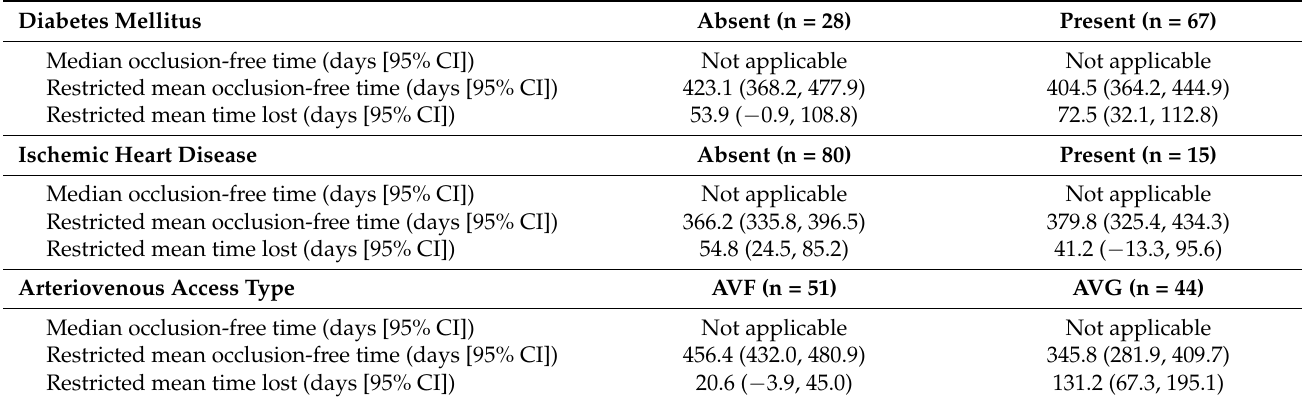
Figure 1. Kaplan‒Meier plots showing the occurrence of complete occlusive access thrombosis during the follow-up periods according to the presence or absence of diabetes mellitus ( a ), presence or absence of ischemic heart disease ( b ), and arteriovenous access type ( c ). The time to the occurrence of complete occlusive access thrombosis was shorter in patients with arteriovenous grafts than in those with arteriovenous fistulas ( p = 0.003 based on log-rank test). The area between the 2 dotted lines represents the 95% CIs of the Kaplan–Meier product-limit estimates. Crosses represent censored patients. Table 6. Kaplan–Meier survival